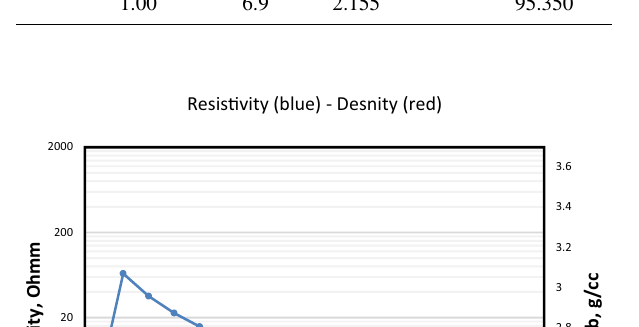
Table 5 Rock responses with clay, V